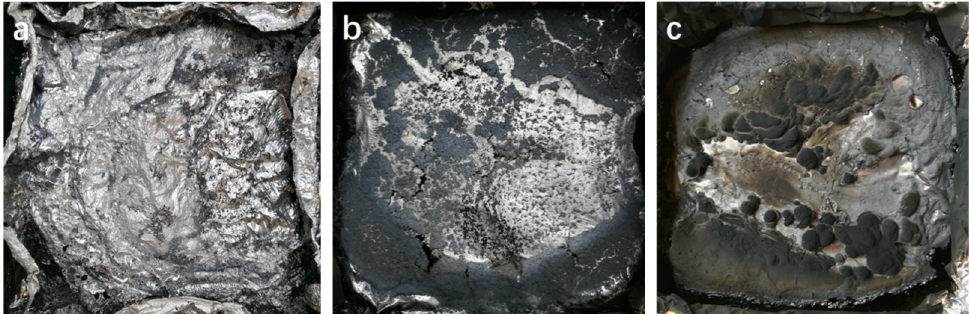
Figure 11. Images of the residues after the CC test: ( a ) residue of WPU; ( b ) residue of G/WPU; and ( c ) residue of BP/GWPU.